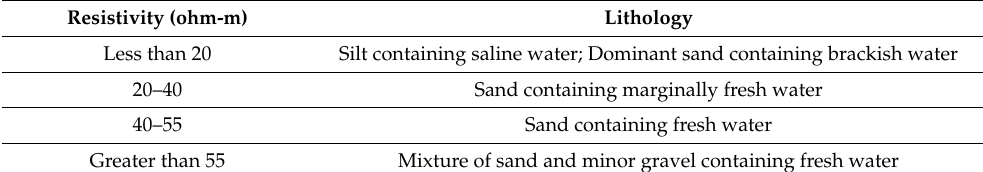
Table 2. True resistivity and aquifer lithology calibration in Lower Bari Doab,